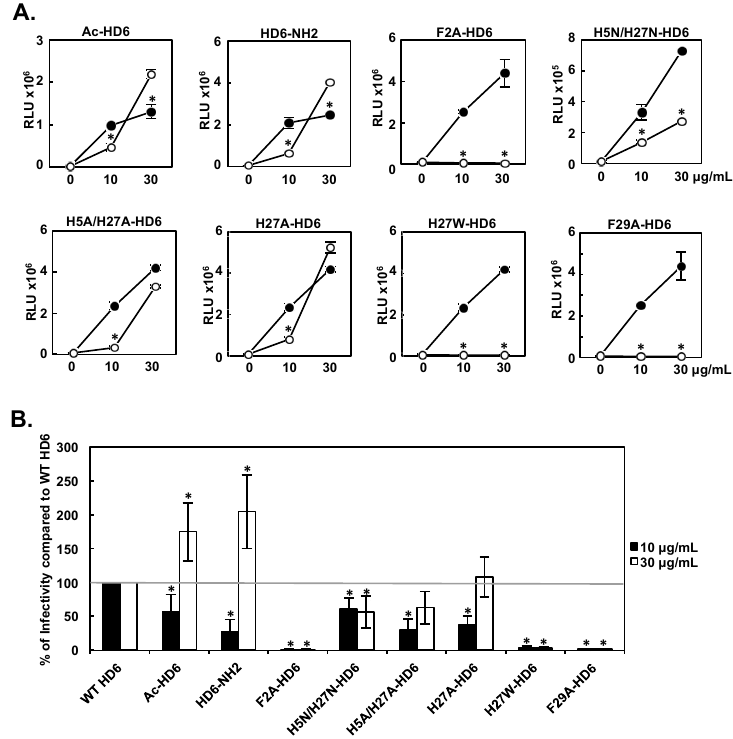
Figure 4. Effect of HD6 mutants on HIV infection-enhancing activity. WT HD6 or HD6 mutants were incubated with serum-free HIV-1 JR-FL for 1 h followed by infection of HeLa-CD4-CCR5 cells. Luciferase activity was measured 48 h after infection. ( A ) Results of a representative independent experiment for each HD6 mutant (open circles) and WT HD6 (filled circles) are shown. The RLUs of cells infected by HIV without defensins were 13,332–76,853. Data are means ± SD of triplicate samples. * p < 0.05, WT HD6 versus HD6 mutants at the same concentration by Student’s t -test. ( B ) Data represent the average relative percent of enhanced HIV infectivity by mutants to WT HD6 at the same concentrations from more than three sets of experiments for each mutant. * p < 0.05, WT HD6 versus HD6 mutants at the same concentration by one-way ANOVA with Bonferroni post-test.